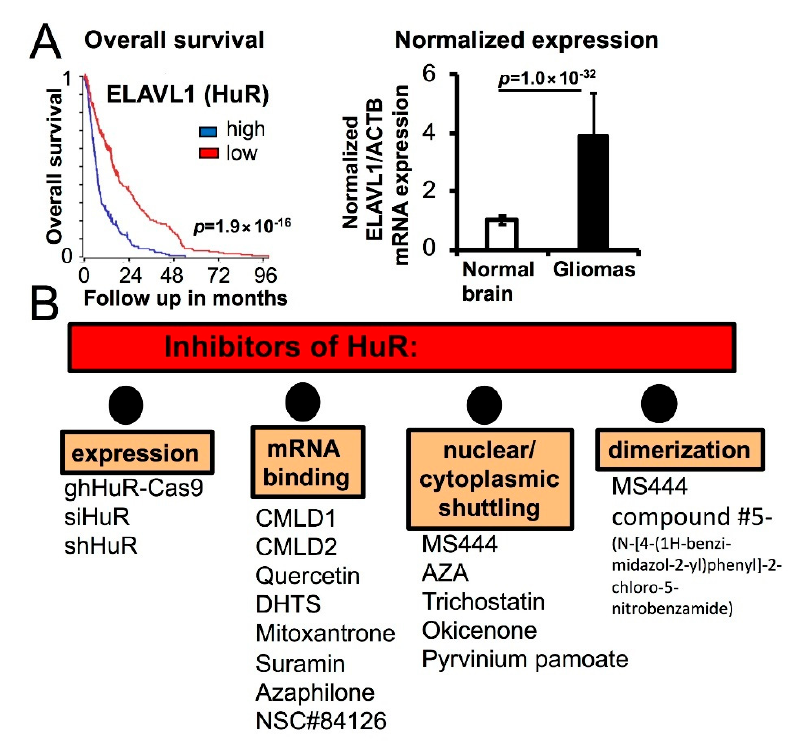
Figure 4. Classes of the available HuR inhibitors. ( A ) Graph (left) illustrates the Kaplan–Meier overall survival curves for patients with gliomas harboring low (red, n = 245) or high (blue, n = 245) expression of the ELAVL1 transcript (Rembrandt, Madhavan, Mas 5.0-U132p2 study from R2: platform, median cut-off modus); the graph (right) illustrates normalized ELAVL1/ACTB expression in gliomas ( n = 500) compared to normal brain ( n = 44). Data are shown as mean ± SD. The following research studies from the R2: platform have been utilized for the analysis: Rembrandt, Madhavan, Mas 5.0-U132p2 study for gliomas and Harris, Mas 5.0-U132p2 study for normal brain. ( B ). Classes of the available HuR inhibitors.